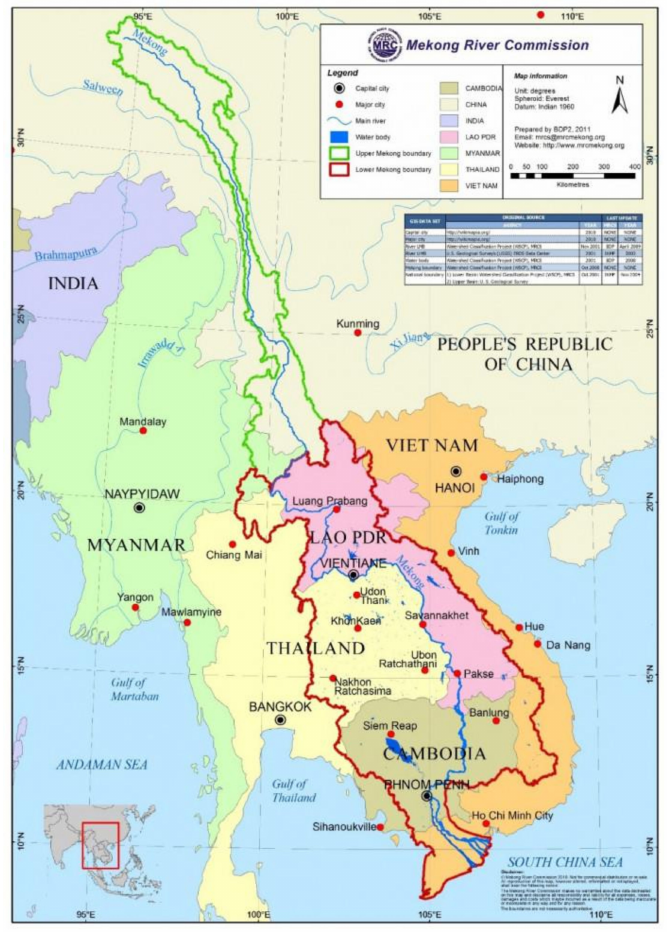
Figure 2. Geographical location of the LMRB